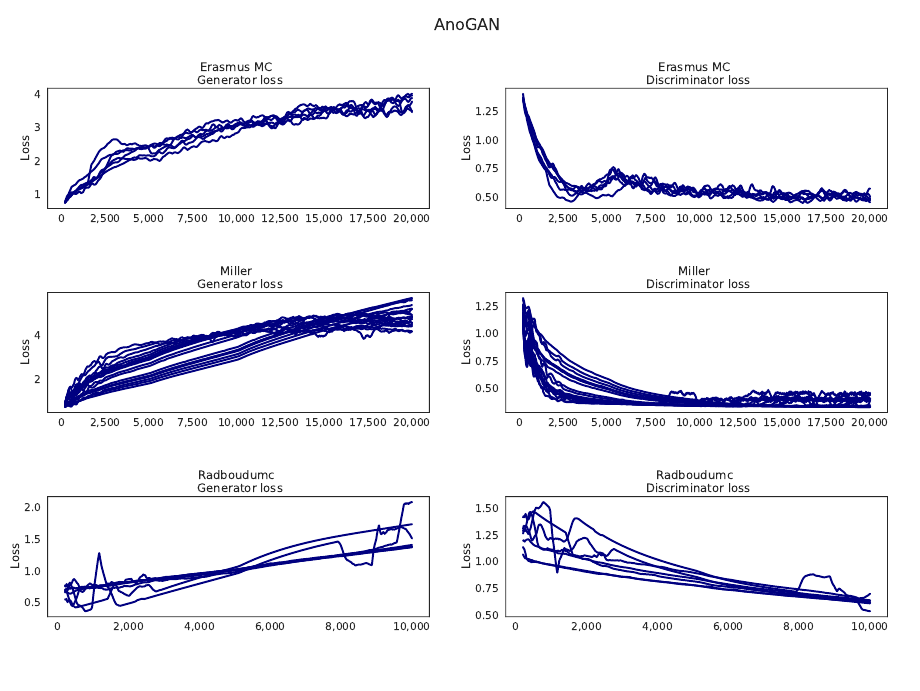
Figure A8. Learning curves for the AnoGAN method. The generator and discriminator loss are displayed in each subplot. Note that each curve represent one cross-validation.